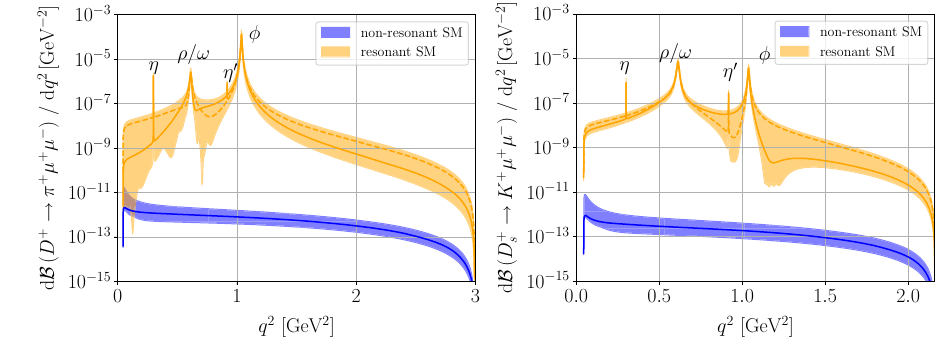
Fig. 2 The differential SM branching fractions of D + → π + μ + μ − (plot to the left) and D + s → K + μ + μ − (plot to the right) decays. Yel- low(blue)bandsshowpureresonant(short-distance)contributions.The bandwidthsrepresenttheoreticaluncertaintiesofhadronicformfactors,